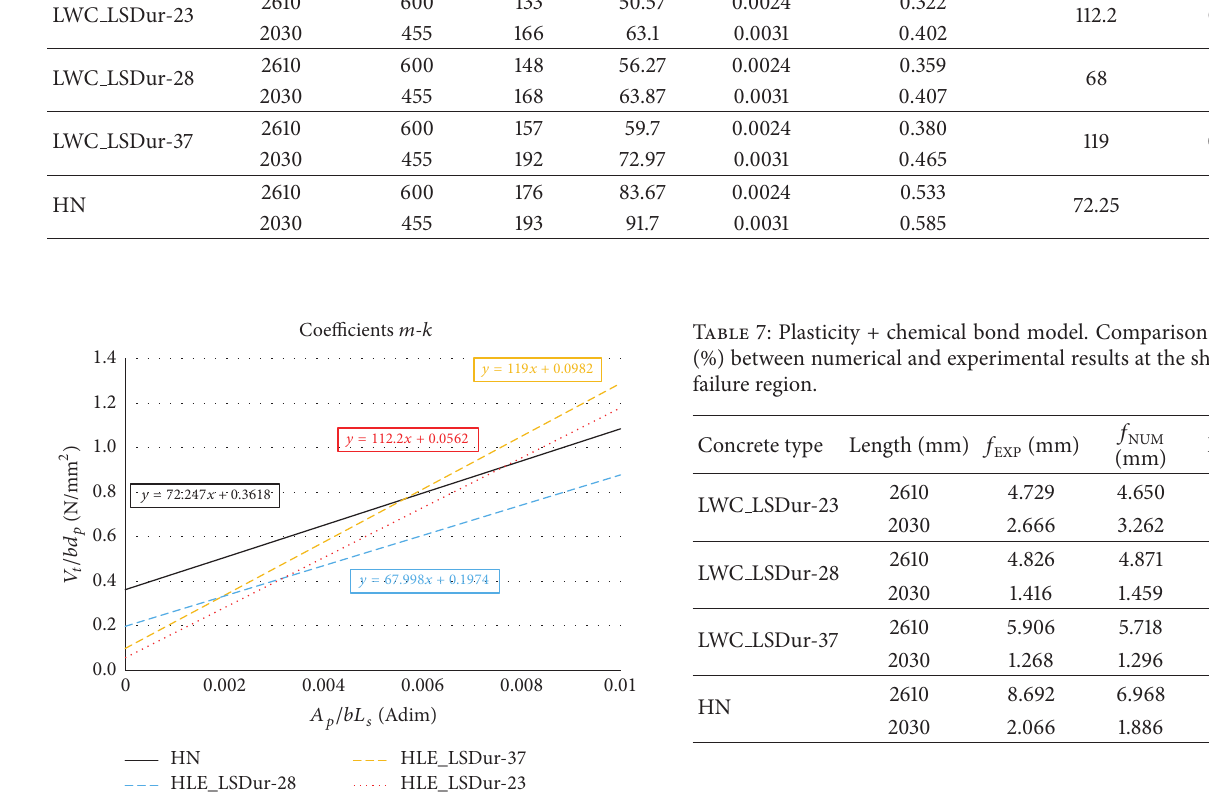
Figure 8: m - k curve fitted for composite slabs tested.